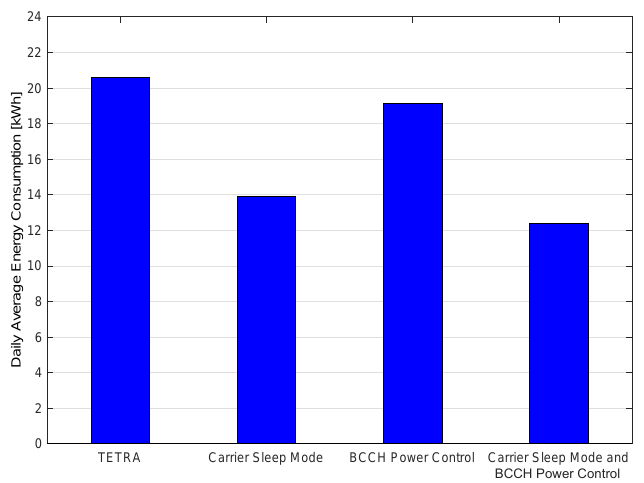
Figure 9. Daily average energy consumption of a single TETRA base